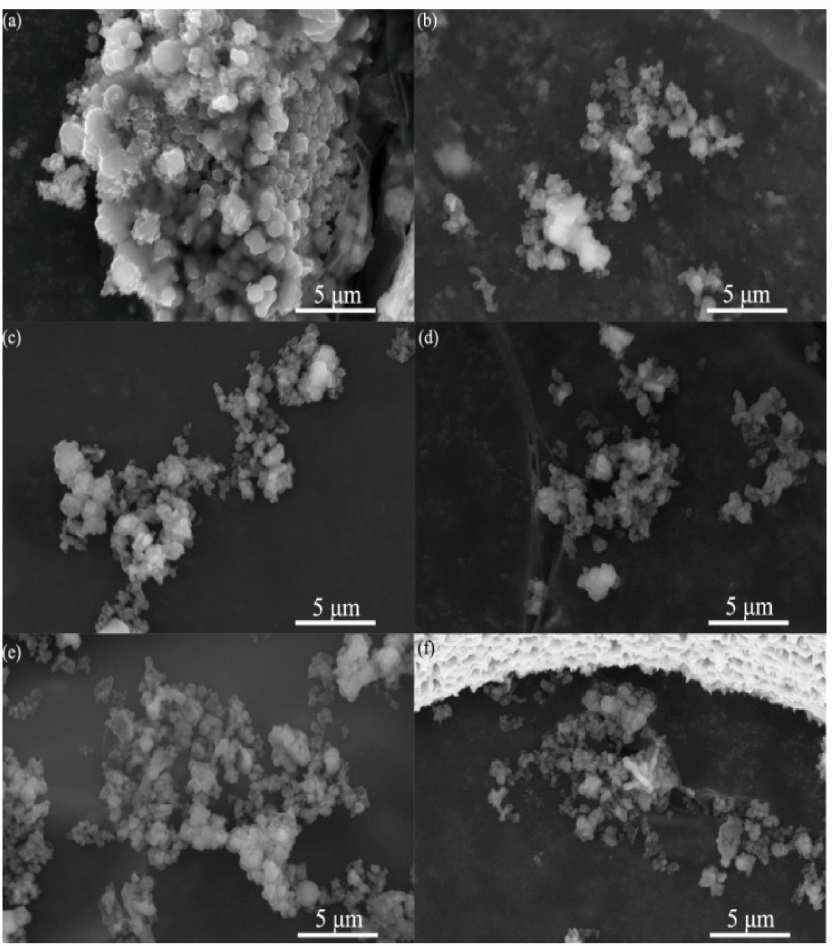
Figure 2. SEM images of the B powder purified with different methods. ( a ) Raw B powder; ( b ) B powder after grinding; ( c ) HCl-purified B powder; ( d ) Grinding+HCl-purified B powder; ( e ) heat